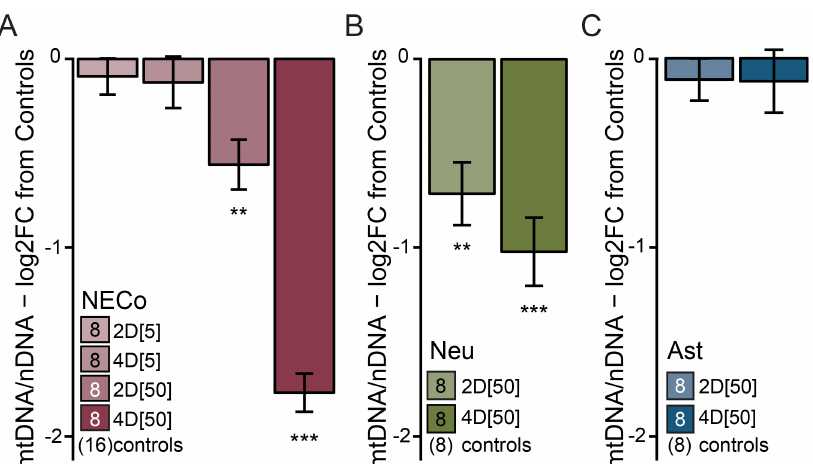
Fig 2. Exposure to EtBr dose- and time-dependently decreasesmtDNA in rat striatal co-cultures and purified neuronal cultures, but not in astrocytes. (A-C) Log2-foldchangein nDNA-normalized mtDNA quantity in responseto EtBr treatment, in (A) neuron-enriched cocultures(NECo), (B) pure neuronalcultures (Neu), and (C) astrocytes (Ast). N for each group is includedin figure legends. *** = p < 0.001, ** = p < 0.01, relativeto vehicle-treatedcontrols followingDunn’spost-hoc